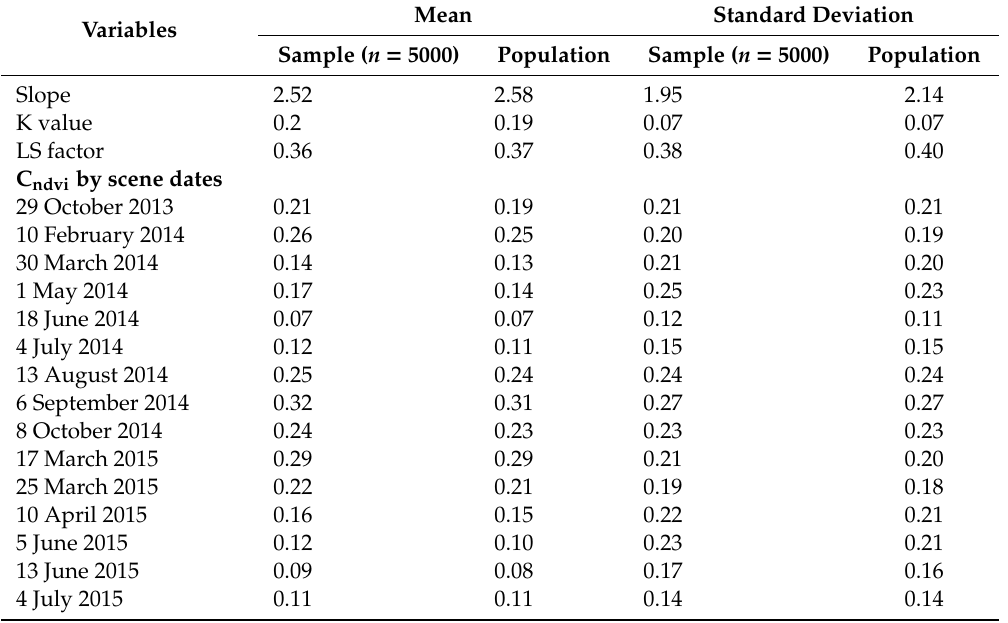
Table A1. Data comparison between randomly extracted data points (samples) and the whole scene statistics (population). The t-test indicated no statistical di ff erence between the two groups ( p =